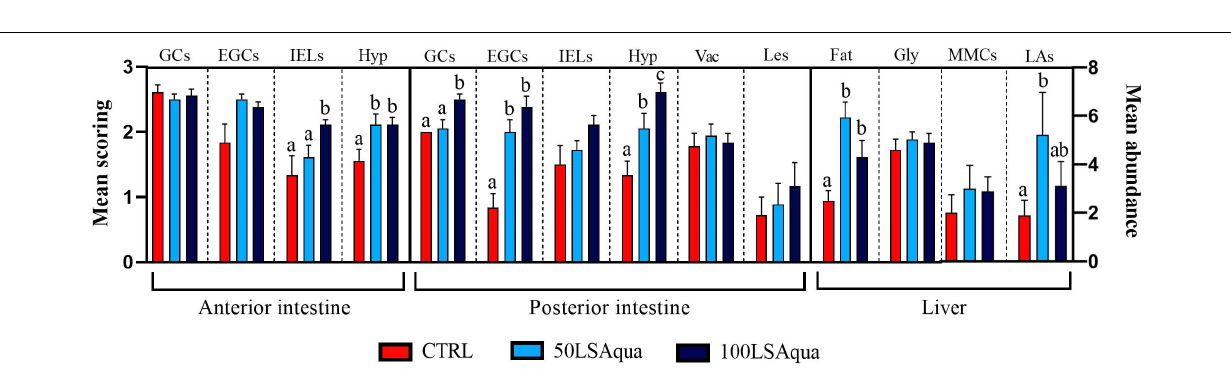
Frontiers in Marine Science |